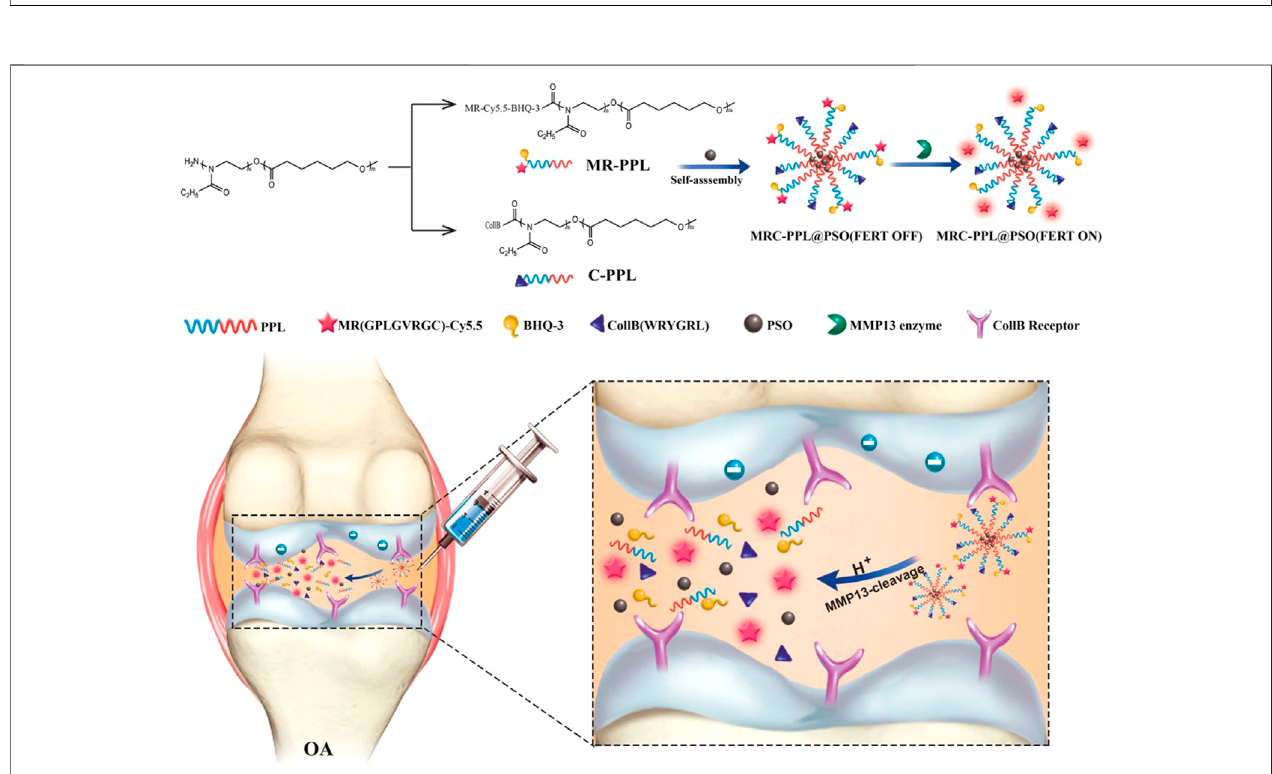
FIGURE 6 | Strategy of MMP-13 and pH responsive theranostic nano-micelles for osteoarthritis. Reproduced with permission (Lan et al., 2020). Copyright 2020, BioMed Central Ltd.